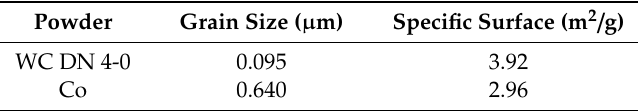
Table 1. Starting powders.